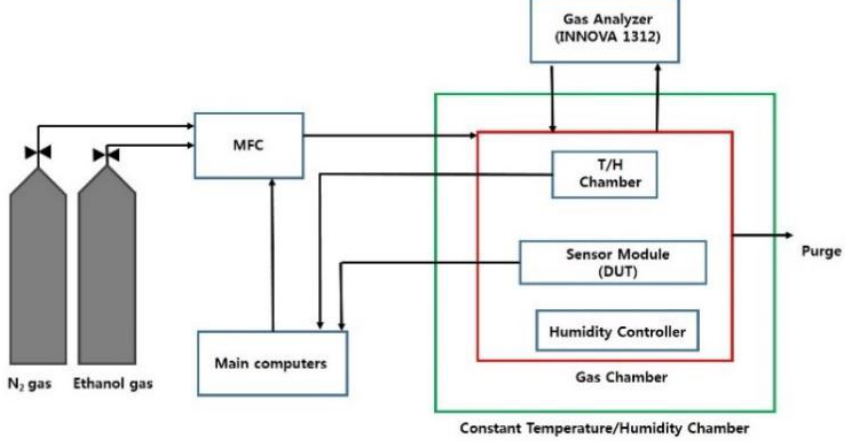
Figure 6. Block diagram of experimental setup. MFC: Mass Flow Controller; DUT: Device Under Test. A multi-gas analyzer (INNOVA-1312, LumaSense Technologies A/S, Ballerup, Denmark) was less. The gas analyzer is calibrated and attached with special filters for accurate ethanol